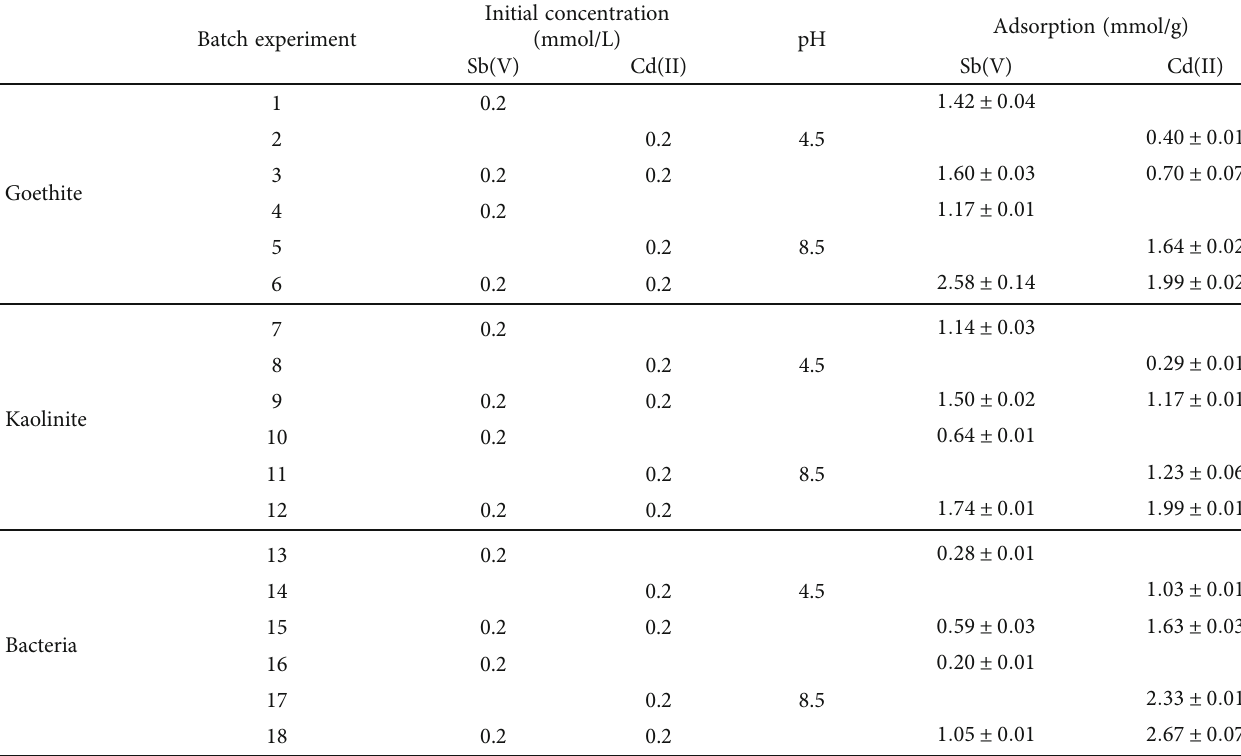
Table 1: Summary of experimental conditions and fi nal adsorption of Sb(V) and Cd(II) for the batch experiments.